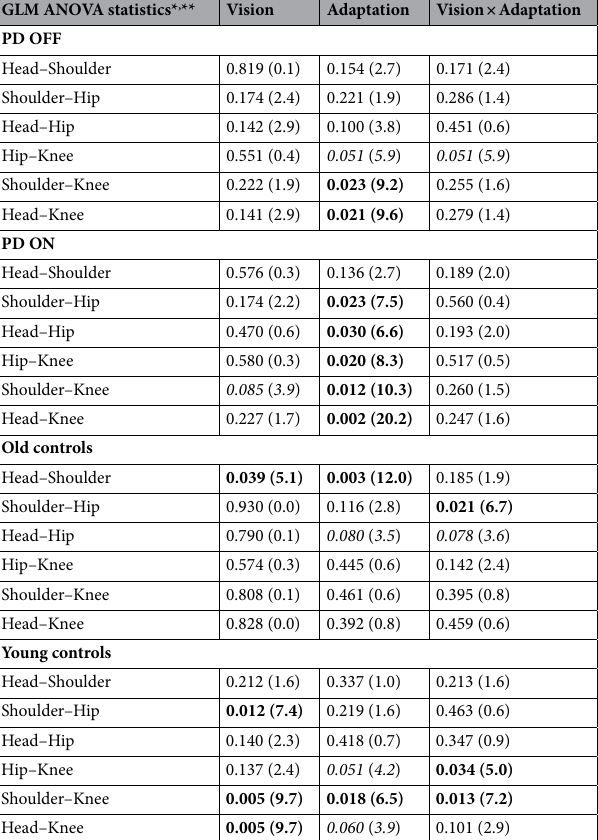
Table 3. Vision and adaptation effects on body movement coordination. *Repeated measures GLM ANOVA of movement patterns with main factors “Vision” and “Adaptation” and their factor interactions. The F-values are presented within the parenthesis. **Significant differences are marked with bold numbers and trends (p < 0.1) are marked with italics